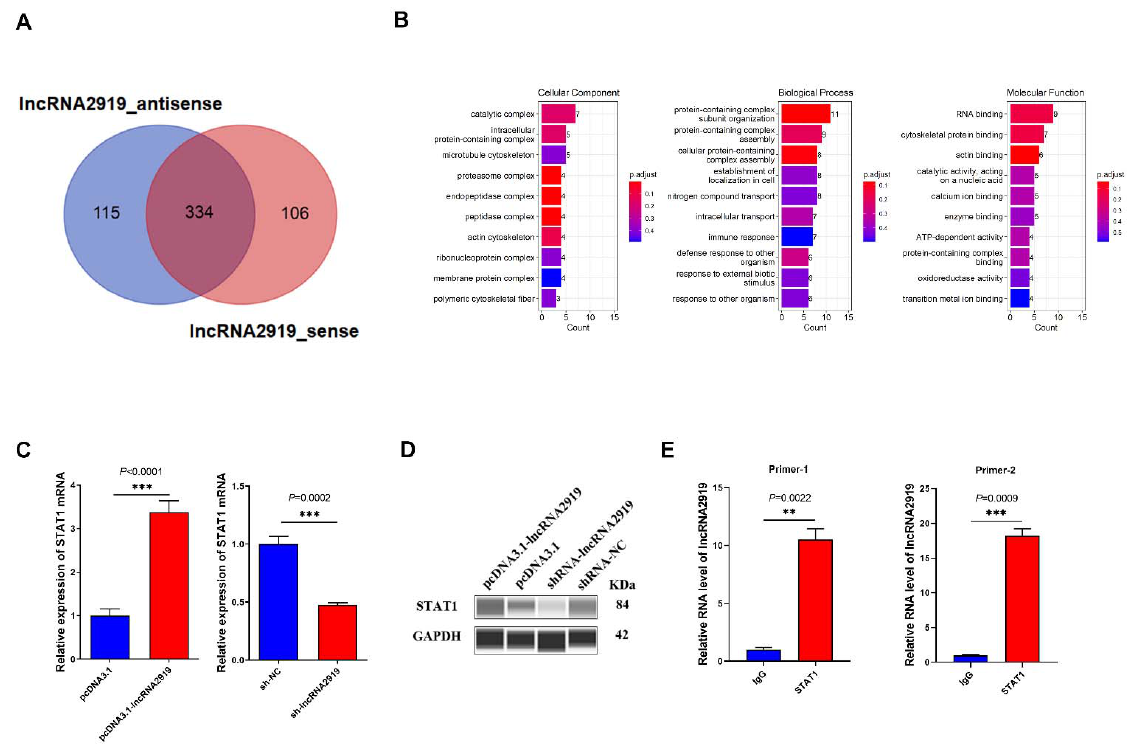
Figure 3. lncRNA2919 regulated the binding protein STAT1. ( A ) Venn diagram shows the number of proteins obtained from the silver staining band of lncRNA2919 from in vitro transcription through mass spectrometry after the RNA pull-down assay. ( B ) The biological function of binding proteins for lncRNA2919 were analyzed through GO term enrichment. ( C ) The STAT1 mRNA ex- pression level after lncRNA2919 overexpression and knockdown. ( D ) The STAT1 protein expression level after lncRNA2919 overexpression and knockdown. ( E ) The interaction between STAT1 and lncRNA2919 was verified through the RIP-qPCR assay. The enrichment of STAT1 and lncRNA2919 was measured through qPCR and normalized to input. The data are presented as mean ± SEM. A two-tailed paired t -test was used for data analyses. As a key TF, STAT1 plays crucial roles in cell proliferation and differentiation, cell apoptosis, and angiogenesis. We noticed that lncRNA2919 may recruit STAT1, and we verified the lncRNA2919–STAT1 relationship. In DPCs, lncRNA2919 overexpression may upregulate STAT1 mRNA and protein expression, and lncRNA2919 knockdown could downregulate STAT1 mRNA and protein expression (Figure 3C,D). Meanwhile,